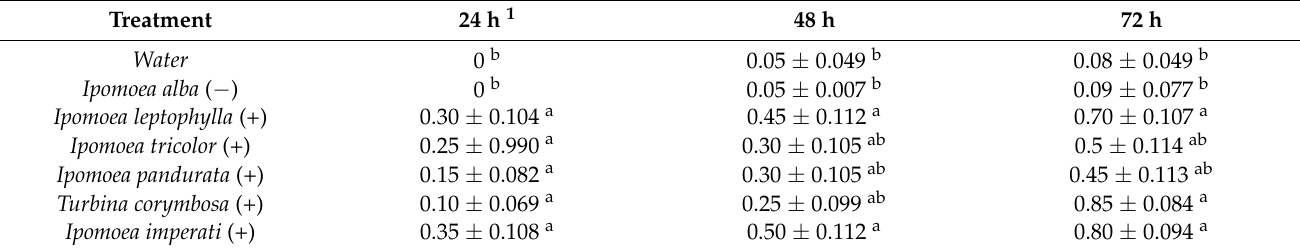
Table 1. Time-dependent mortality rates (proportion) of Diaphornia citri nymphs exposed to leaves treated with crude extracts from Convolvulaceae plant species. (+) Periglandula -positive species; ( − ) Periglandula negative